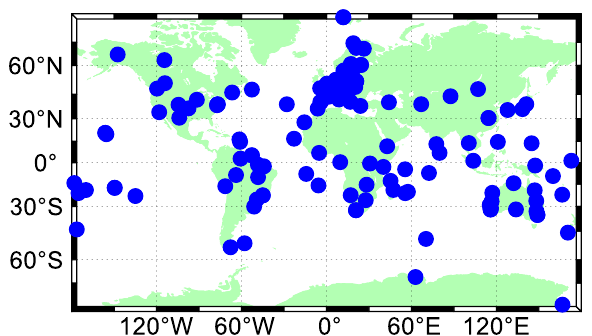
Figure 2. Geographical distribution of stations used in the analysis.